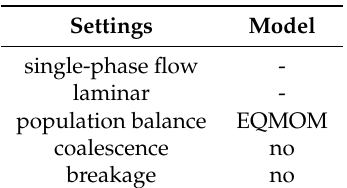
Table 14. Models used in the simulations of Test Case 3.